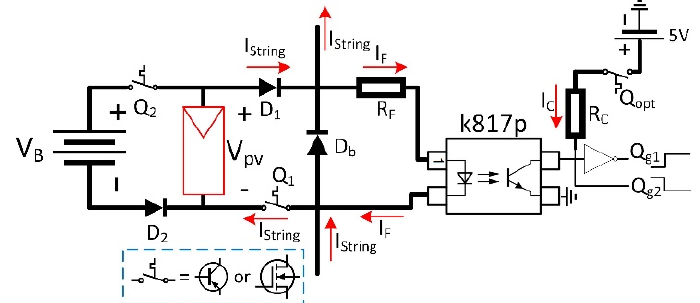
Figure 4. Circuit for isolating the PV module using the proposed optocoupler circuit.